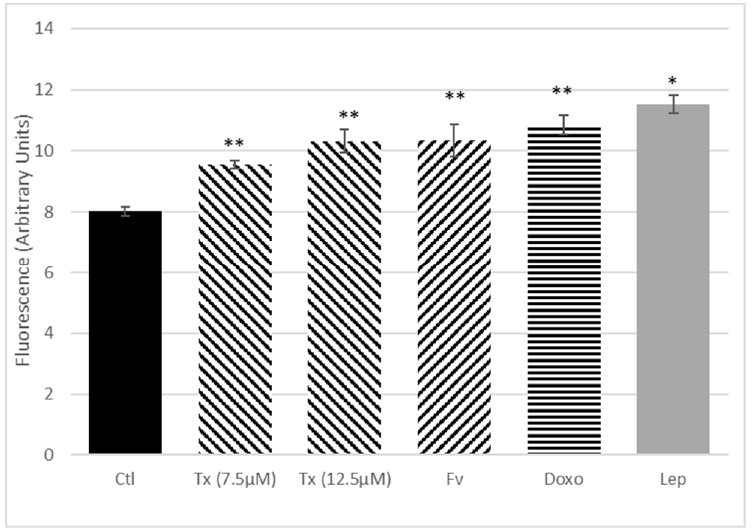
Figure 9. Effect of anticancer treatment, leptin, and Il-6 on the proliferation of isolated side-population (SP) cells. After adhesion, SP cells were treated with different anticancer therapies, i.e., tamoxifen (Tx) at 7.5 and 12.5 µM, fulvestrant (Fv) at 0.3 nM, doxorubicin (Doxo) at 0.1 µM, or with leptin at 1000 ng/mL for 24 h. Cell proliferation was quantified using the resazurin fluorescence test. Bars give means of fluorescence intensity in arbitrary units (AU) ± SEM. Analyses covered three independent experiments; * p < 0.05, ** p < 0.01, treated vs. control.